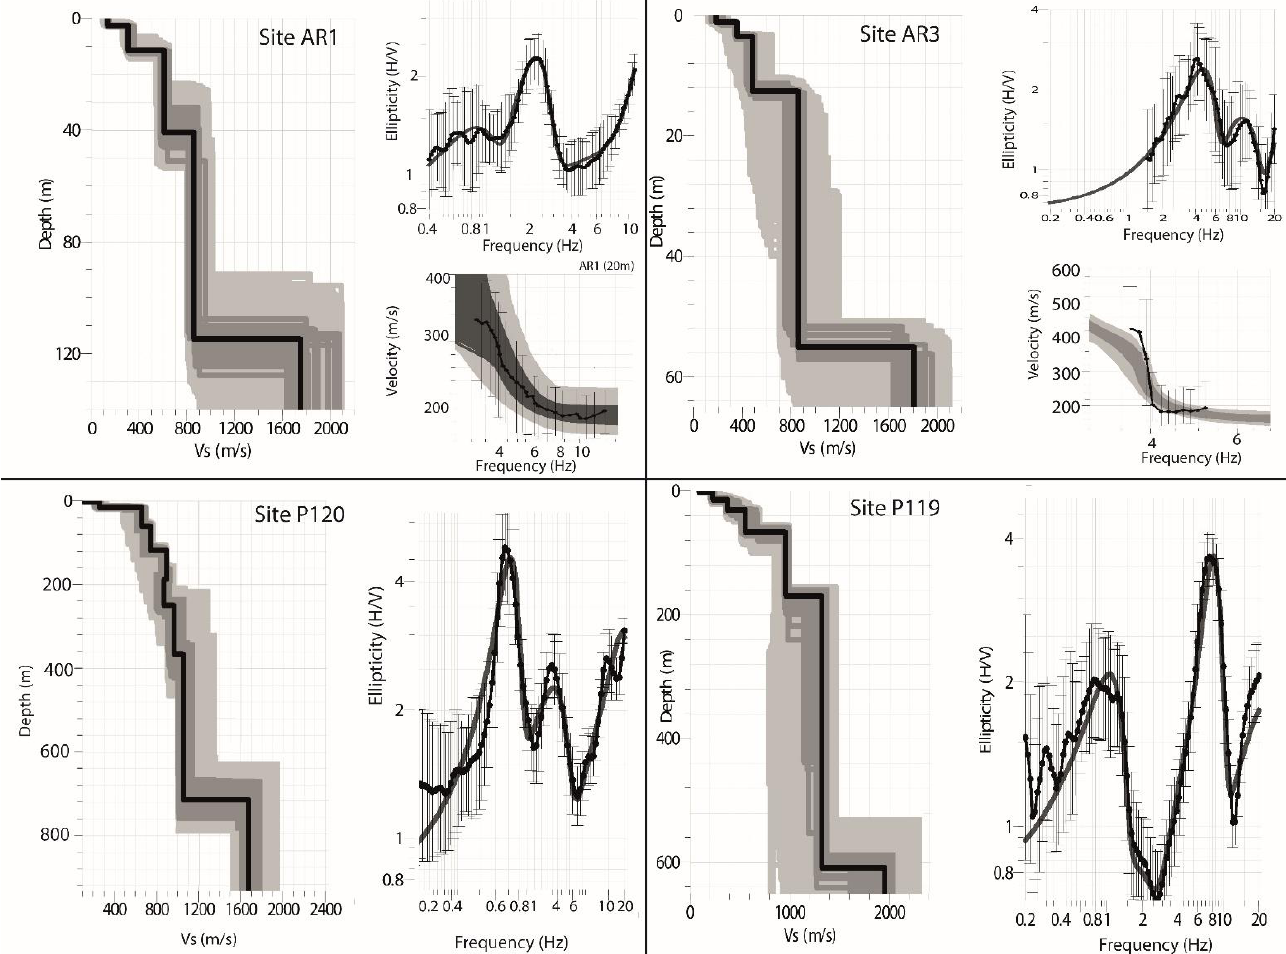
Figure 12. Examples of the inversion results. For each site, the left panels for each site represent the Vs models. The black line corresponds to the best fit model, the dark grey represents models with minimum misfit + 10%. All the tested models are in light grey. In the right panels, we show the computed fundamental mode of the Rayleigh wave ellipticity curve (dark grey curve), and the inverted part of the HVSR curve (black dotted curve). For sites AR1 and AR3, the bottom of the right panel represents the surface wave dispersion curve.